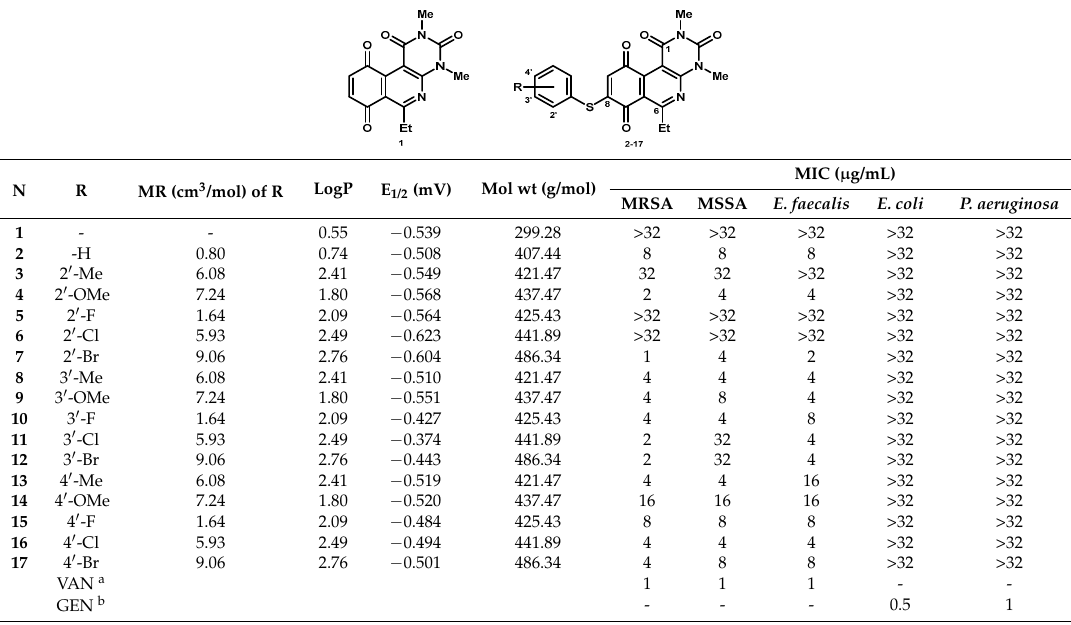
Table 1. Antibacterial screening and physicochemical parameters for compounds 1 – 17 .